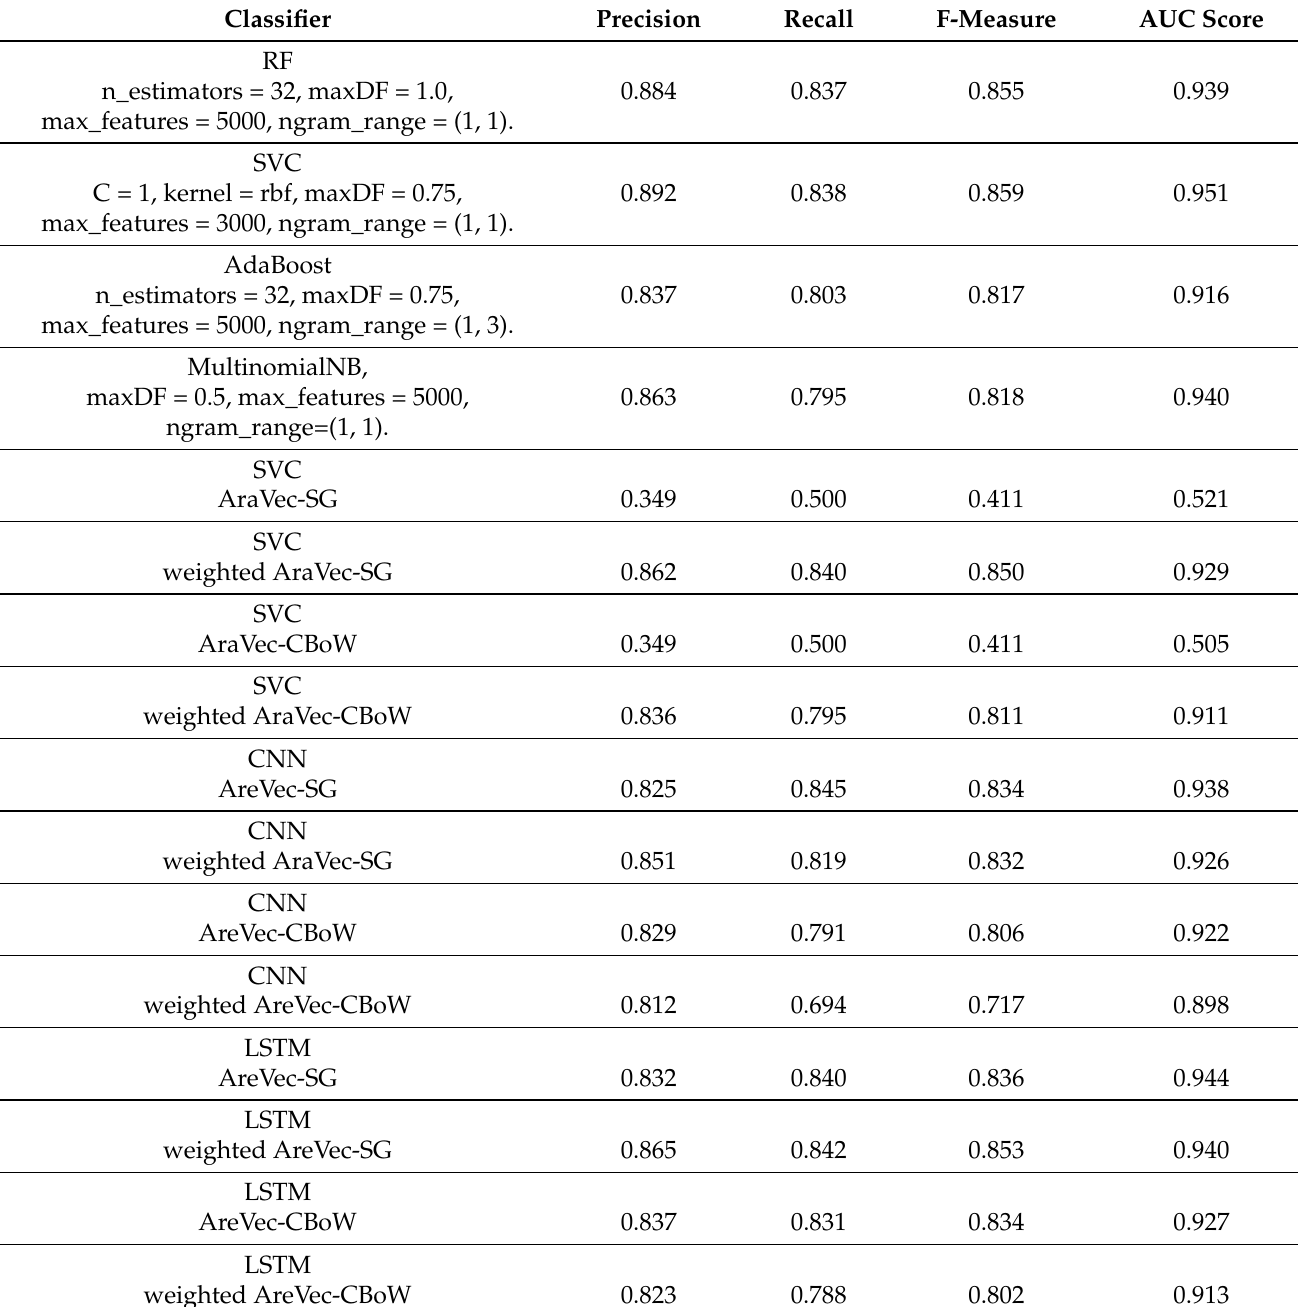
Table 6. The overall performance of the classical and deep machine-learning